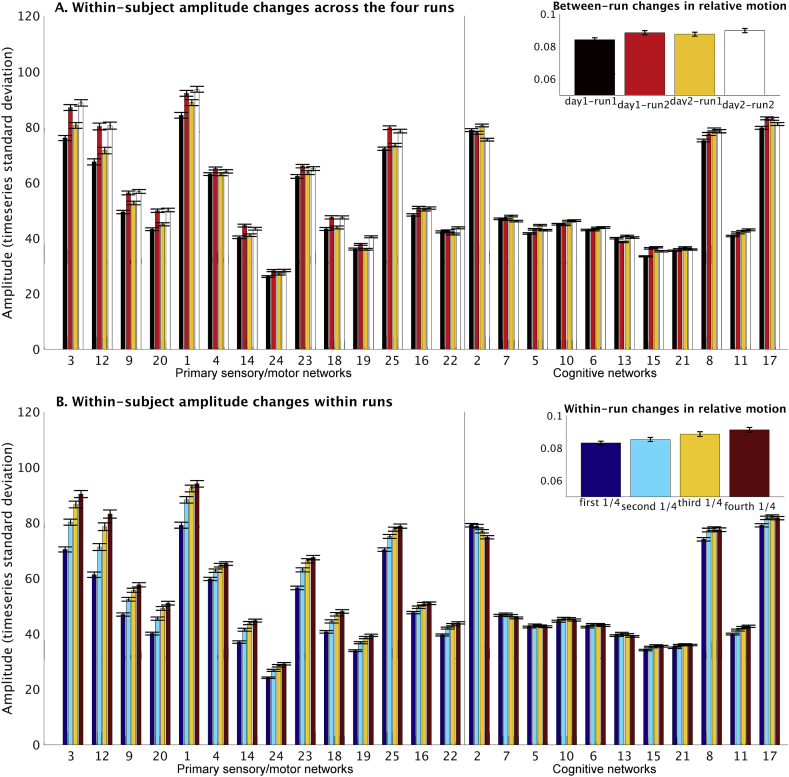
Within-subject variability in network amplitude. Figure A on the top shows amplitude changes across four runs, revealing that BOLD amplitudes in the primary sensory/motor networks were generally higher in the second scan compared with the first scan on both days. These finding cannot be explained by different phase encode directions for the runs (see supplementary results for more details). Figure B on the bottom shows amplitude changes within runs (across four 4-min blocks). The primary sensory/motor networks show a general increase in amplitude from the start of the run to the end, whereas a slight decrease in amplitude was observed in the DMN (IC 2; two-tailed t-tests showed that within-subject slopes were significant different from zero for each of the 4 runs: t1(818) = 10.0, p = 2.1*10−22; t2(818) = −7.1, p = 2.0*10−12; t3(818) = −8.8, p = 9.3*10−18; t4(818) = −3.6, p = 0.0003). The figure insets in the top right corner of A and B show changes in relative subject head motion between runs and within runs respectively. Error bars represent standard error of mean.